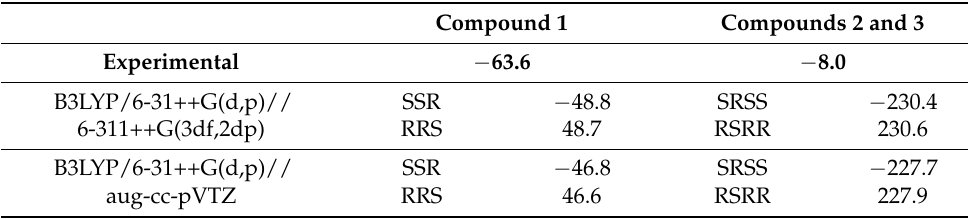
Table 3. Experimental and computed optical rotation values for compounds 1 – 3